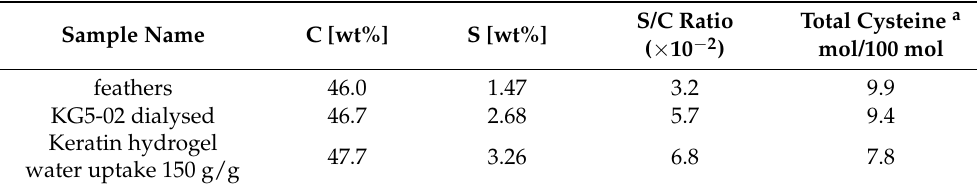
Table 2. Carbon and sulphur content analysis for feathers and keratin